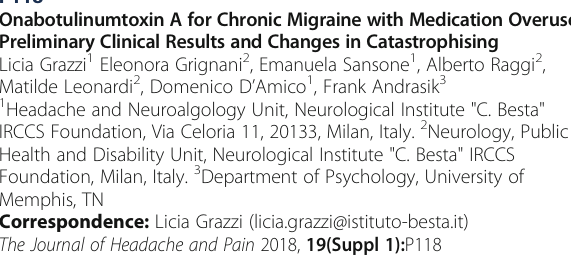
Peng2011, Taiwan